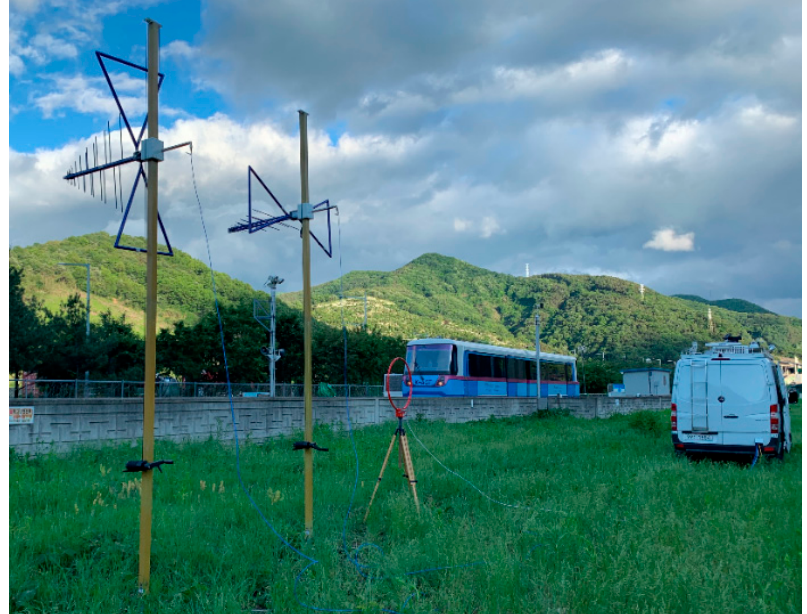
Figure 10. Radiation emission measurement location.